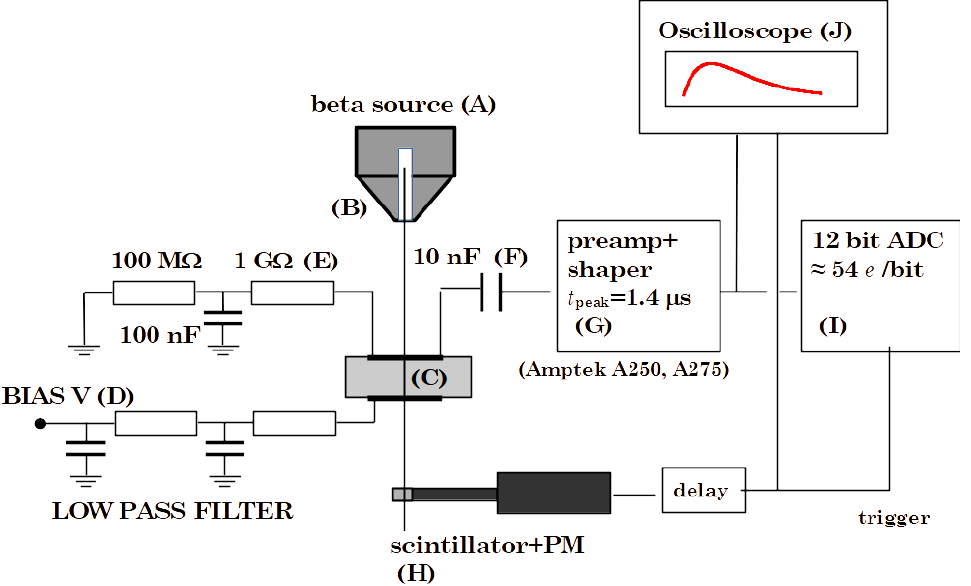
Figure 2. Charge CollectionEfficiency measurement setup developed by Fred Hartjes (NIKHEF, Amsterdam). ( A ), beta source, ( B ), collimator, ( C ), device under test, ( D ), power supply, ( E ), 1 G Ω load resistor, ( F ), decoupling capacitor, ( G ), Amptek shaper, ( H ), trigger, ( I ), PCI NI ADC Board, ( J )